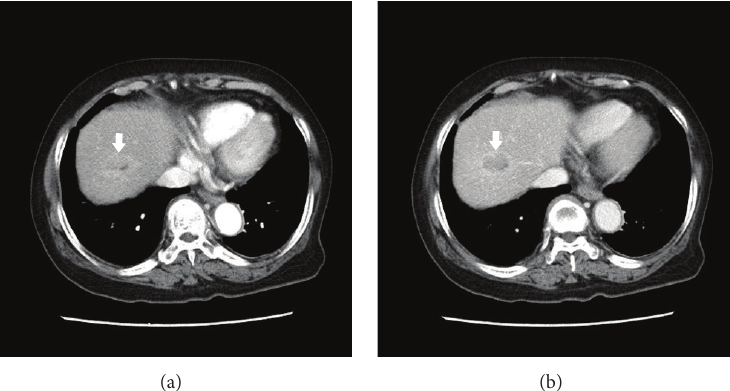
Figure 1: (a) Arterial phase, faintly enhanced mass. (b) Portal vein phase, hypodense nodule.